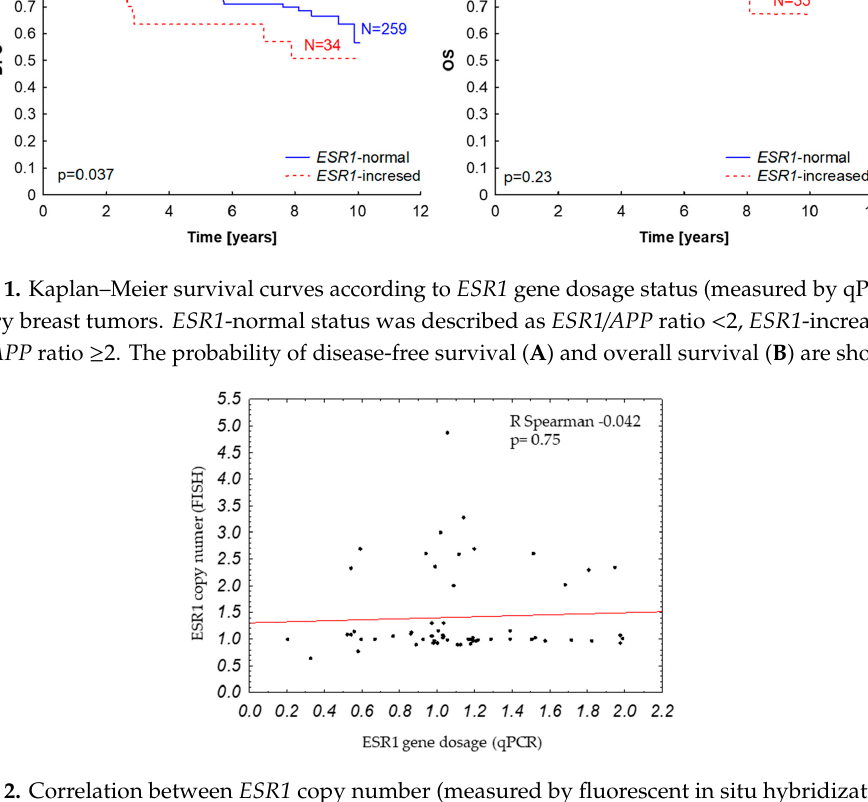
Figure 2. Correlation between ESR1 copy number (measured by fluorescent in situ hybridization, or FISH) and ESR1 gene dosage (measured by qPCR).